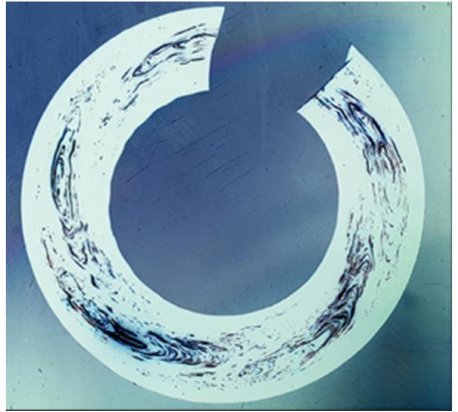
Figure 8. Color-inverted image of sample 4 (100- µ m shaving in Figure